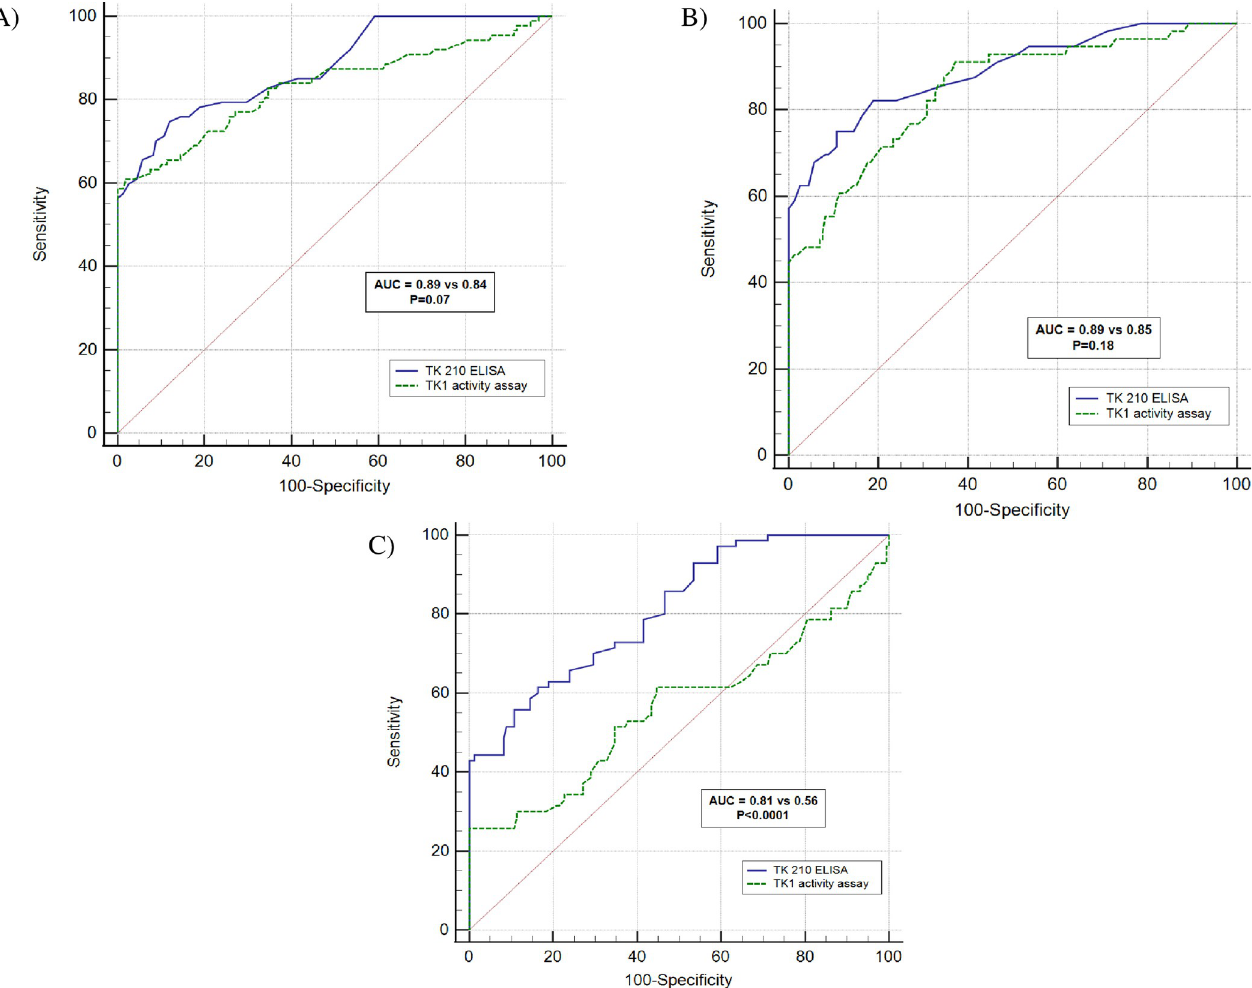
Fig 9. Receiver operating characteristic (ROC) curve comparison between two assays in different malignancies. (A) Comparison of ROC curves for TK 210 ELISA and TK1 activity assay in differentiation of hematological malignancies from blood donors. (B) Comparison of ROC curves for TK 210 ELISA and TK1 activity assay in differentiation of breast cancer from blood donors. (C) Comparison ROC curves analysis of TK 210 ELISA and TK1 activity assay in sera from blood donors and prostate cancer patients.